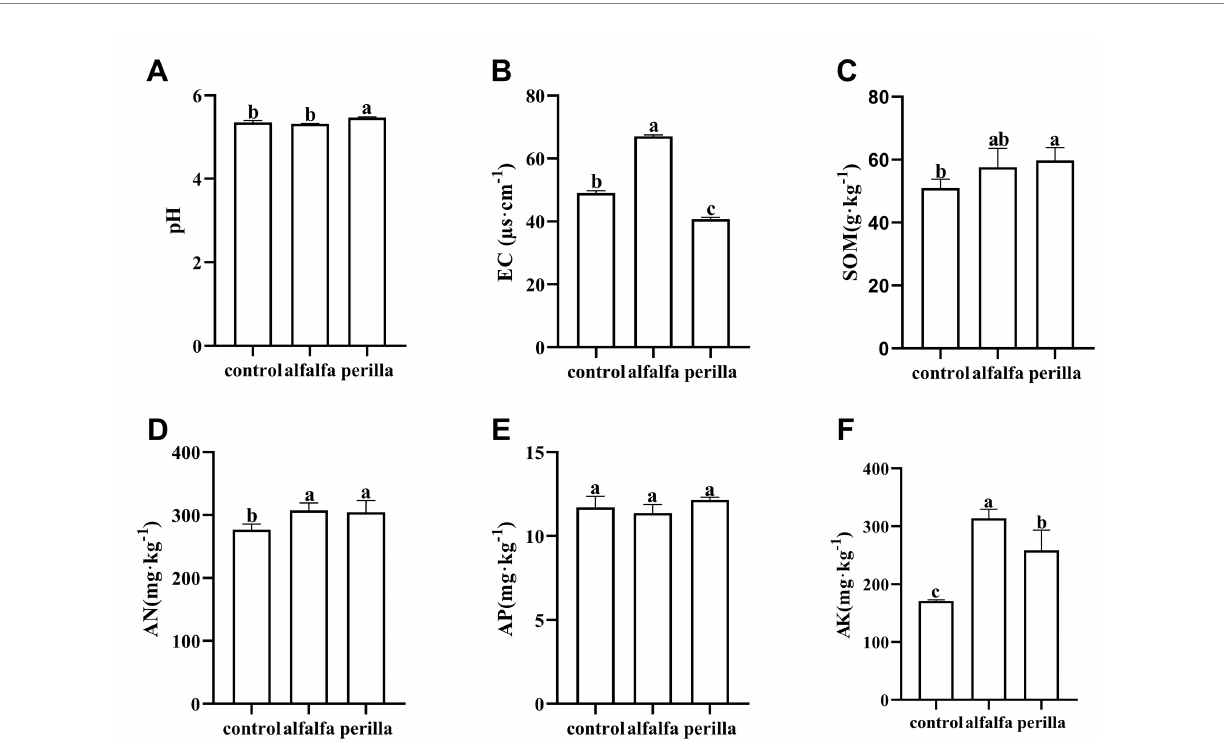
FIGURE 1 Physicochemical properties and nutrient content of the soil in different treatments. Control, no treatment; Alfalfa, alfalfa cultivation; Perilla, perilla cultivation. (A) pH; (B) EC, electric conductivity; (C) SOM, soil organic matter; (D) AN, available nitrogen; (E) AP, available phosphorus; (F) AK, available potassium. Error represents the standard deviation; different letters indicate a significant difference at the p < 0.05